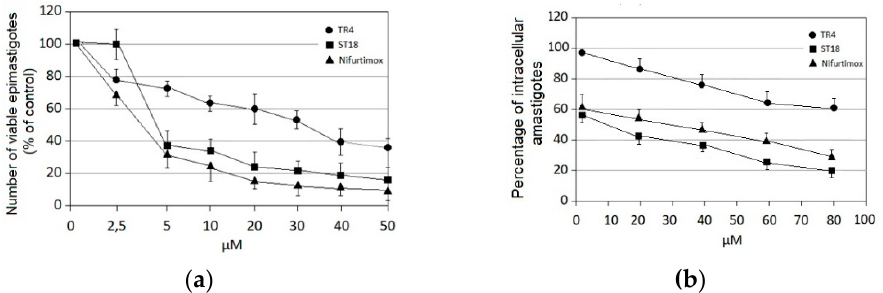
Figure 1. Effects of the compounds Nifurtimox, ST18 and TR4 in Trypanosoma cruzi epimastigotes and intracellular amastigotes. ( a ) Number of viable T. cruzi epimastigotes expressed as percentage of untreated control after 72 h exposure to increasing concentrations of Nifurtimox, ST18 and TR4. ( b ) Number of intracellular amastigotes expressed as percentage of the untreated control after 72 h treatment with Nifurtimox, ST18 and TR4. Bars indicate the means ± SEs from four independent experiments. Data obtained are statistically significant at p < 0.05.